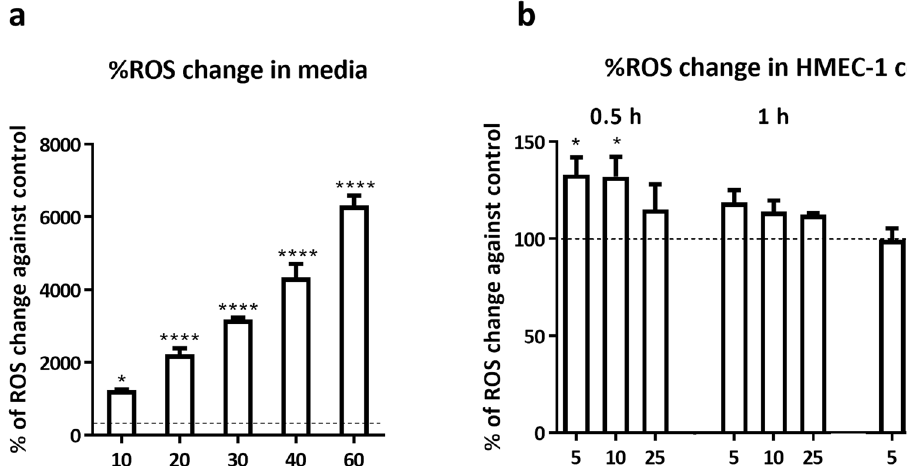
Figure 3. Effects of Dextran-Catechin treatment on HMEC-1 intracellular copper concentration and ROS level. ( a ) The change in ROS level in media following addition of Dextran-Catechin after 24 h incubation. Columns , n = 3, bars , SEM ( * p < 0.05, **** p < 0.0001). ( b ) The ROS level in HMEC-1 cells after Dextran-Catechin treatment. Columns , n = 3, bars , SEM ( * p < 0.05, *** p < 0.001, **** p <